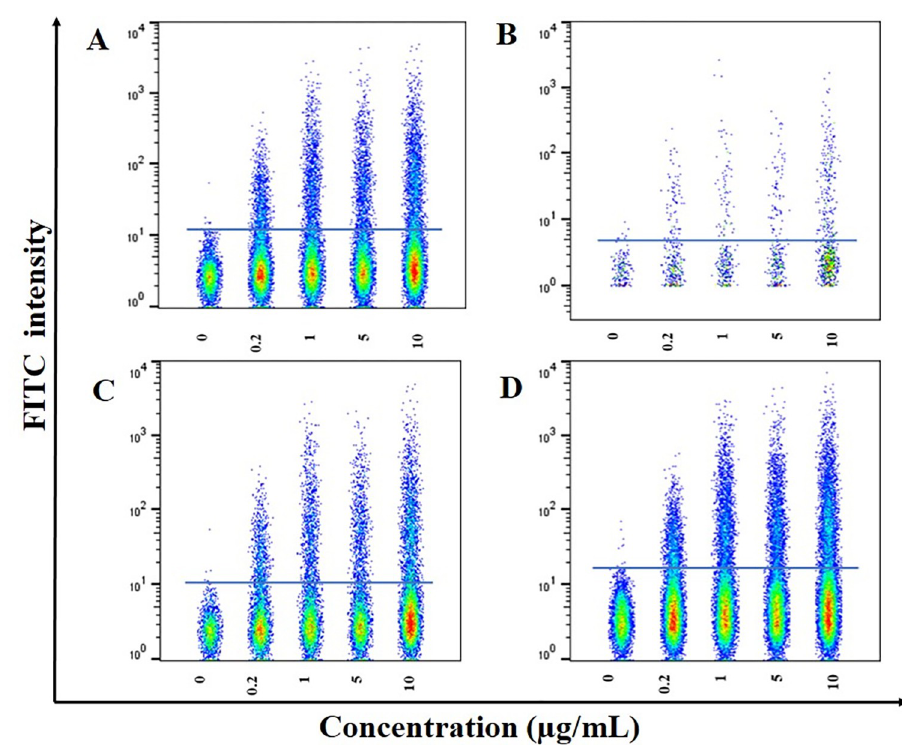
Fig 2. The flow cytometry binding analysis of Fc fusion proteins with engineered CHO-K1 cells in 0, 0.2, 1, 5, and 10 μ g/mL concentrations. Binding capacity was detected by FITC mouse anti-human IgG and using stable cell lines engineered A) human PD-1 (CHO-K1/hPD-1) B) human CD28 (CHO-K1/hCD28) C) human CTLA4 (CHO-K1/ hCTLA4), and D) human 4-1BB